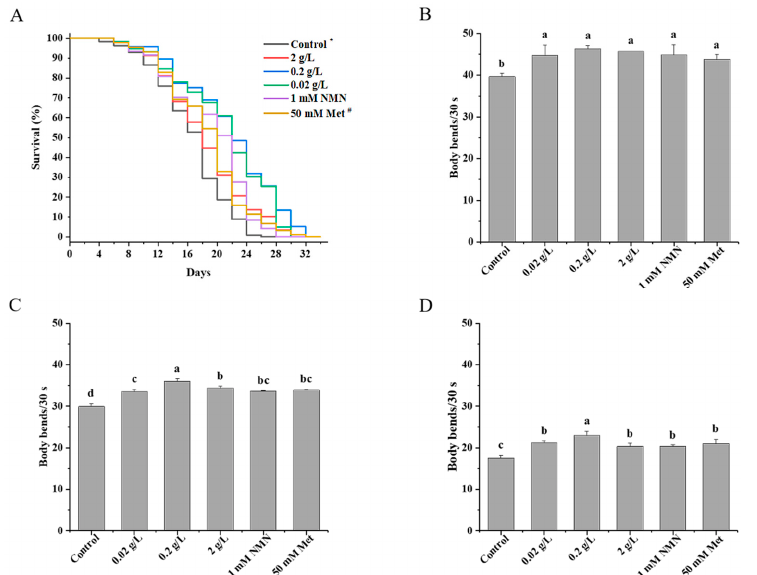
Figure 1. ( A ) Effect of different doses of QBLP on the lifespan of C. elegans . ( B – D ) Effect of different doses of QBLP for 6 days, 9 days, and 12 days on the locomotion of C. elegans . * Control indicates the control group (no additional QBLP was added to the medium). # Met indicates metformin hy- drochloride. Different letters indicate significant differences between groups ( p < 0.05). The data are the mean ± SEM. Table 1. Effect of QBLP supplementation on the lifespans.